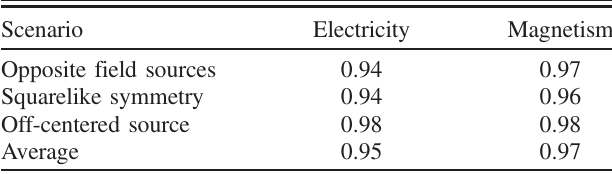
TABLE I. Interrater reliability of the phenomenographic analy- sis for each scenario and context.